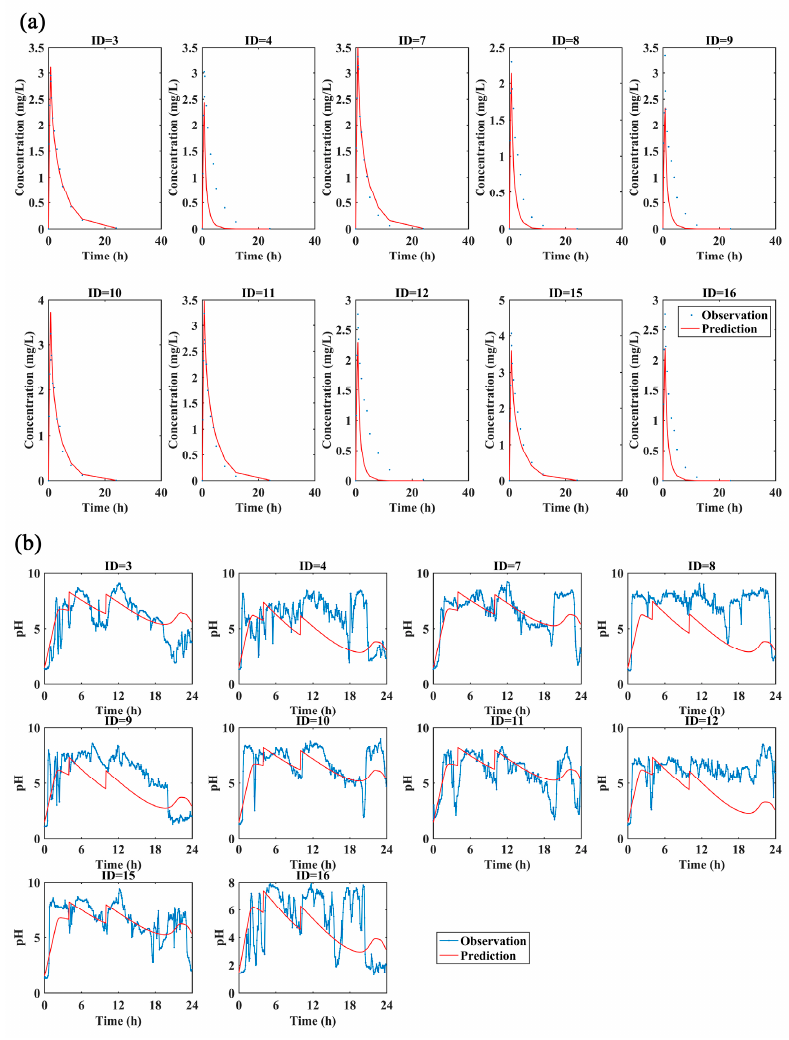
Figure 3. ( a )The observed and predicted plasma concentration-time curves and ( b ) the observed and